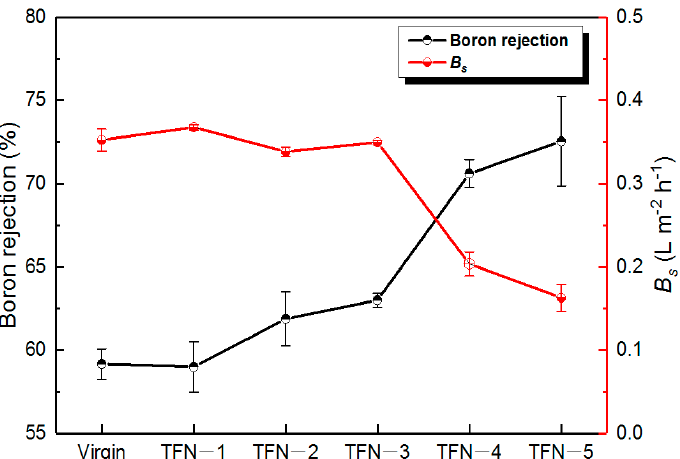
Figure 11. Rejection and permeability coefficients of 5 ppm boron through the RO membranes.